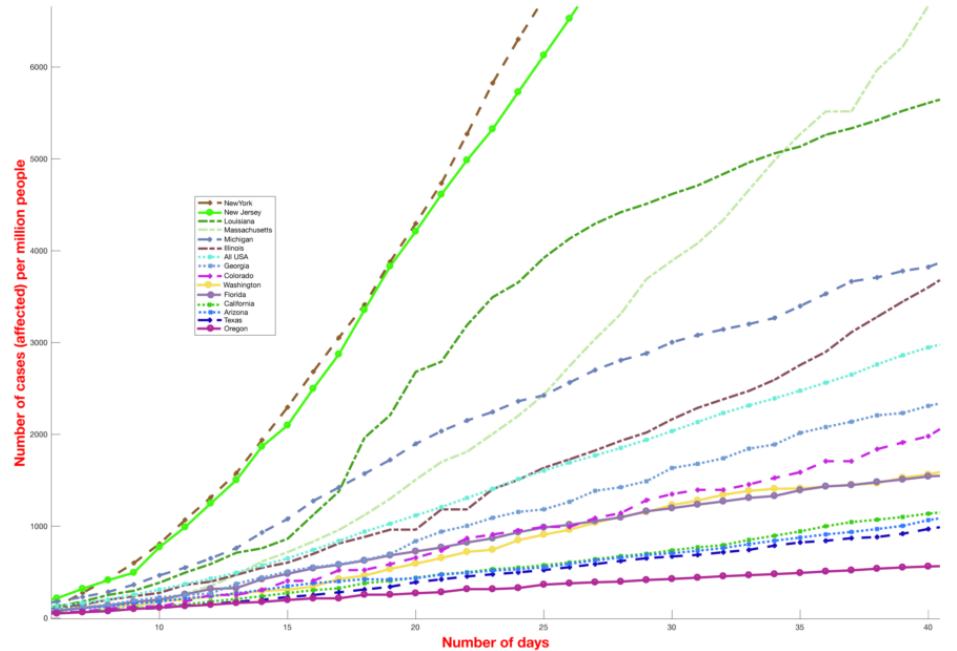
Figure 2. Incidence curve of COVID-19 cases for different US states (until 1 May 2020). The figure shows the total number of cases (normalized by the population of the state) starting from 20 persons affected per million. The y -axis has been capped at 6000 cases per million.